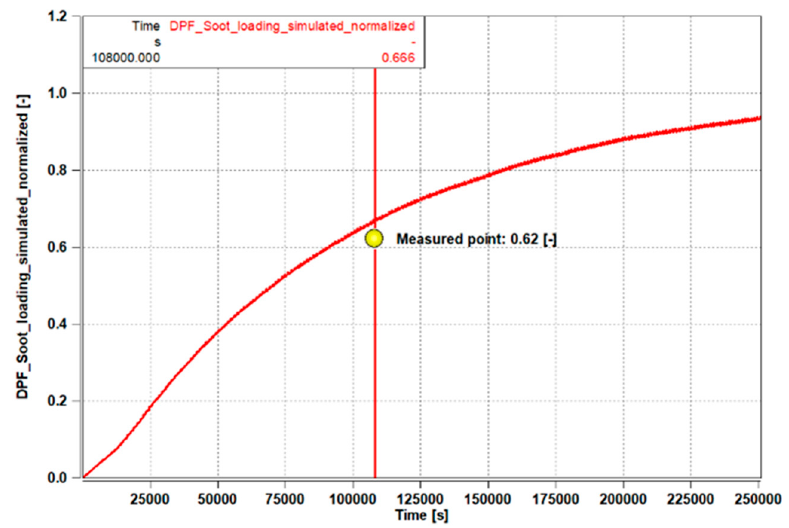
Figure 28. Soot Loading comparison between HiL simulation and real engine test bed (normalized with respect to the maximum value reached in the test).